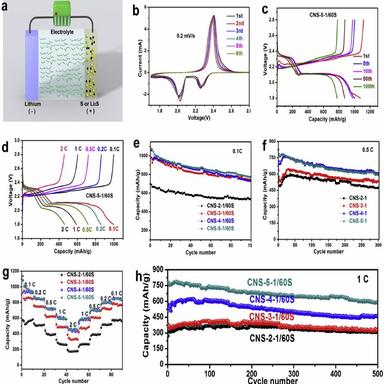
Electrochemical characterization of assembling lithium-sulfur batteries devices based on various CNS materials. a) Schematic illustration of the device configuration. b) CV curves of CNS-5-1/60S measured between 1.7 and 2.8 V versus Liþ/Li at a sweep rate of 0.2 mV s1 . c) Charge-discharge profiles at a current density of 0.1 C of CNS-5-1/60S cathode. d) Charge-discharge profiles at different rates of CNS-5-1/60S cathode. e) and f) are cycling performance curves of CNS-X-1/60S (X ¼ 2, 3, 4, 5) electrodes at